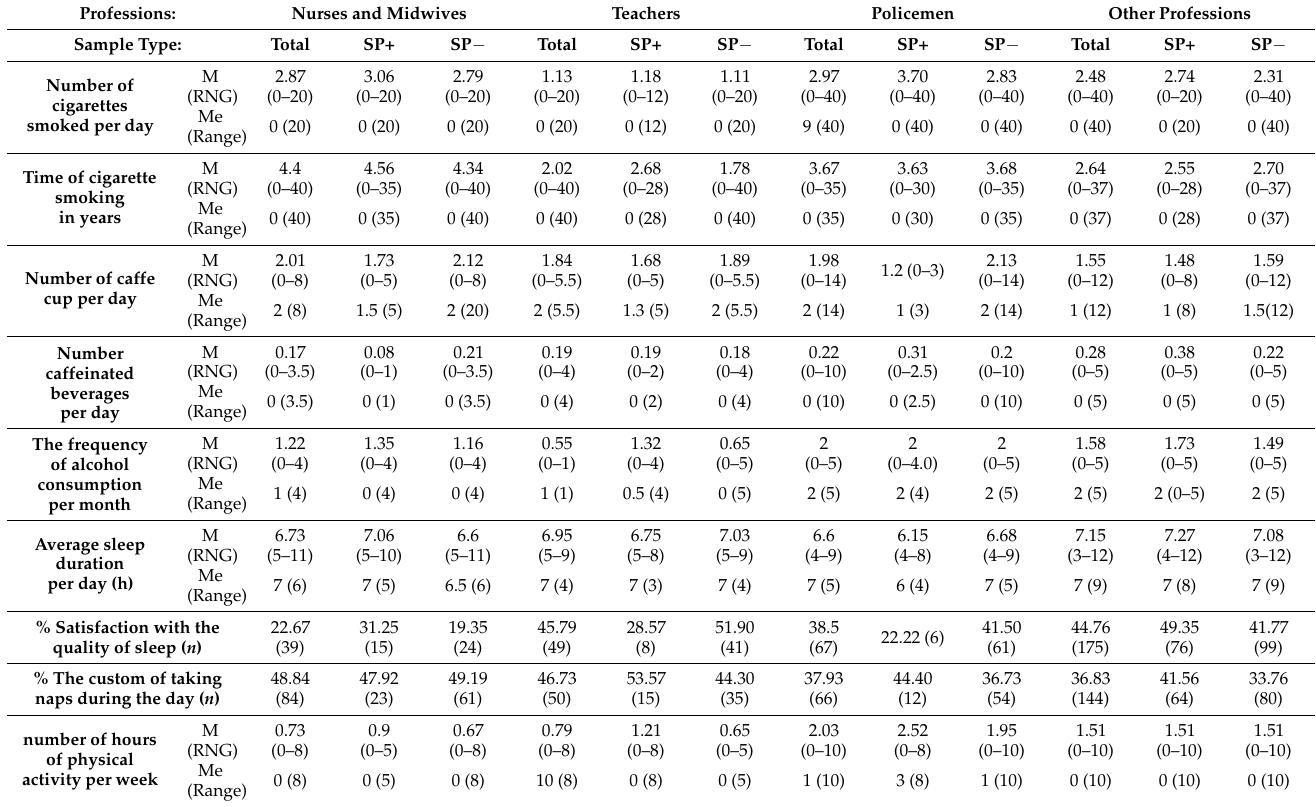
Table 3. Lifestyle characteristics of participants, by profession group.